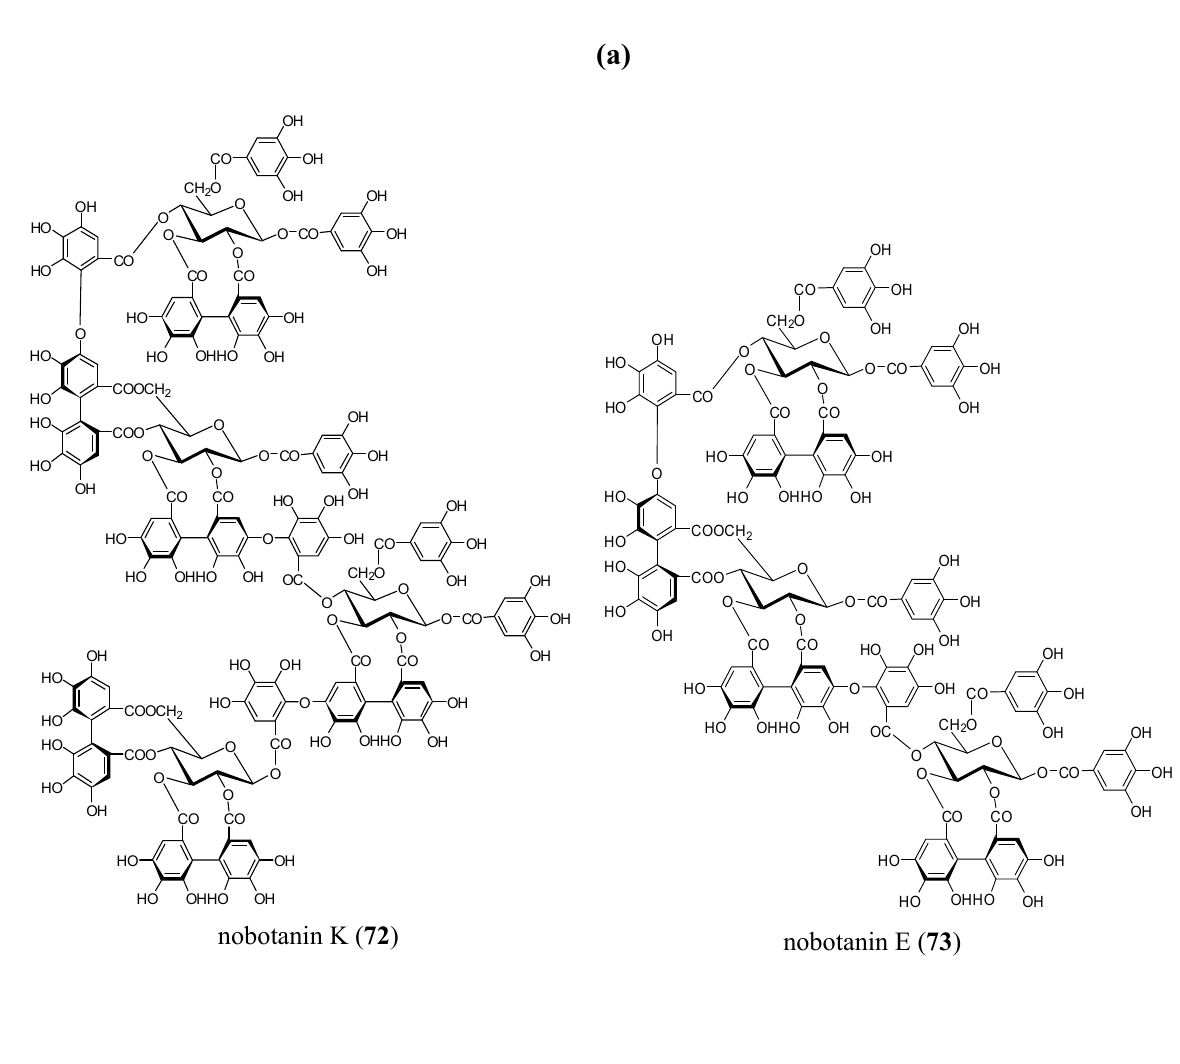
Figure 11. (a) Structures of ellagitannin oligomers 72 and 73 . (b) Structures of ellagitannin oligomers 74 – 77